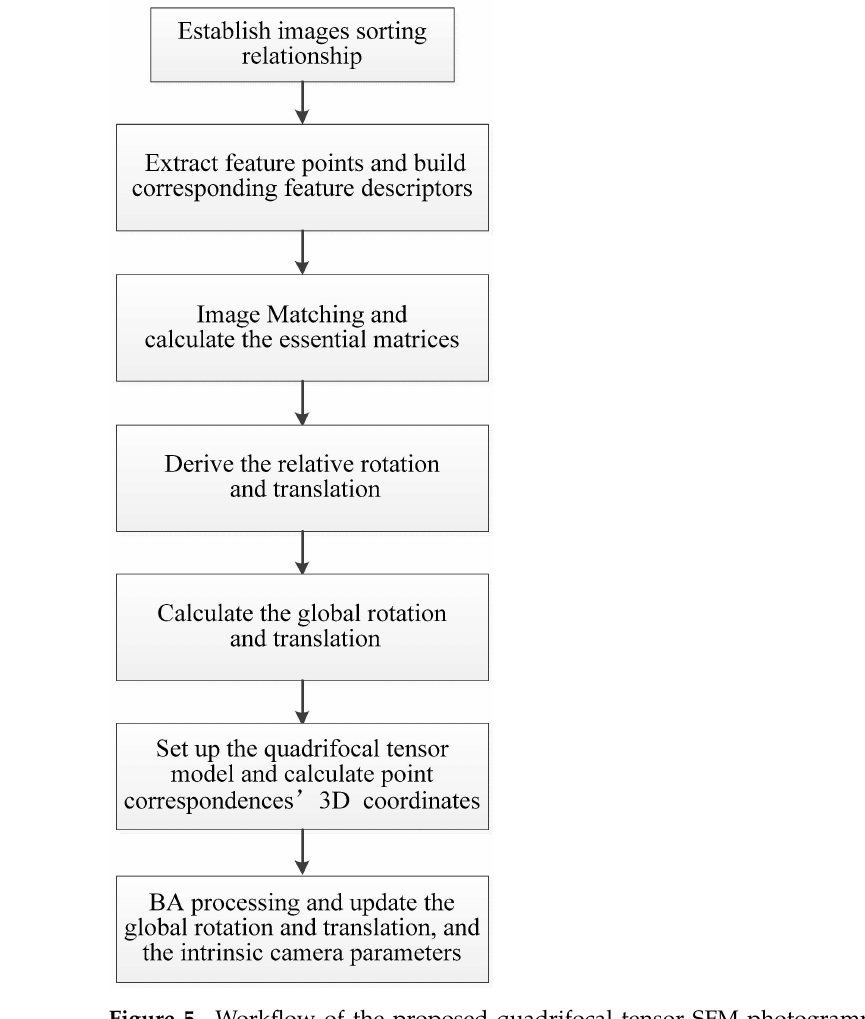
Figure 5. Workflow of the proposed quadrifocal tensor SFM photogrammetry positioning and calibration